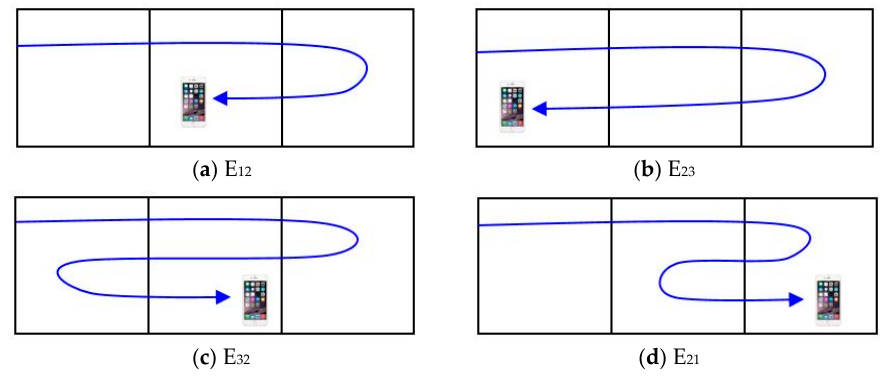
Figure 4. Examples of states E ij . : ( a ) E 12 ; ( b ) E 23 ; ( c ) E 32 ; ( d ) E 21.